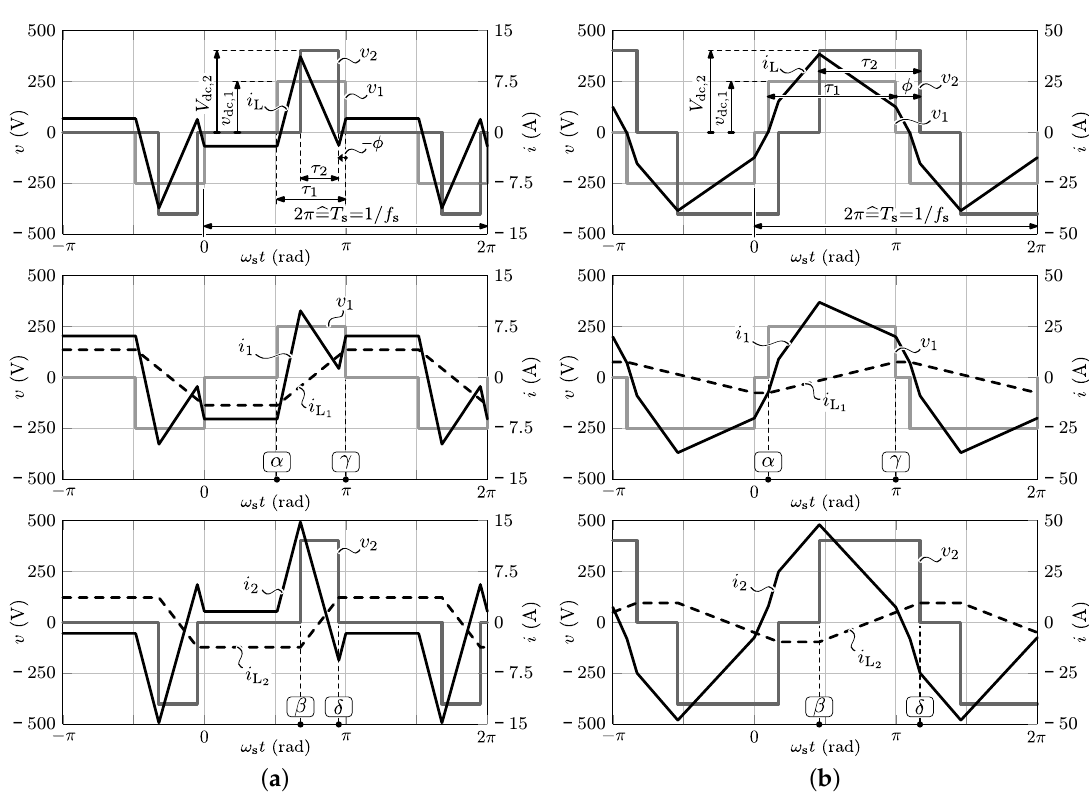
Figure 4. Ideal high-frequency (HF) ac-link voltage/current waveforms for ( a ) Switching mode 1: